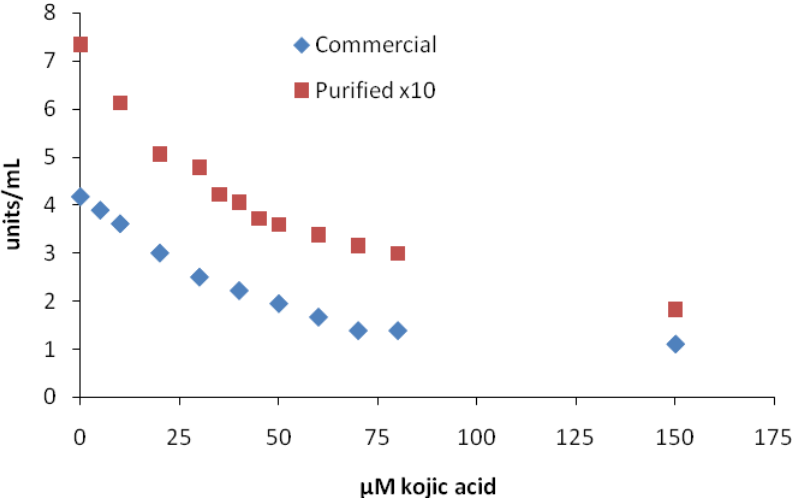
Figure 1. Inhibition of mushroom tyrosinase by kojic acid. Assays were carried out as described in the Experimental